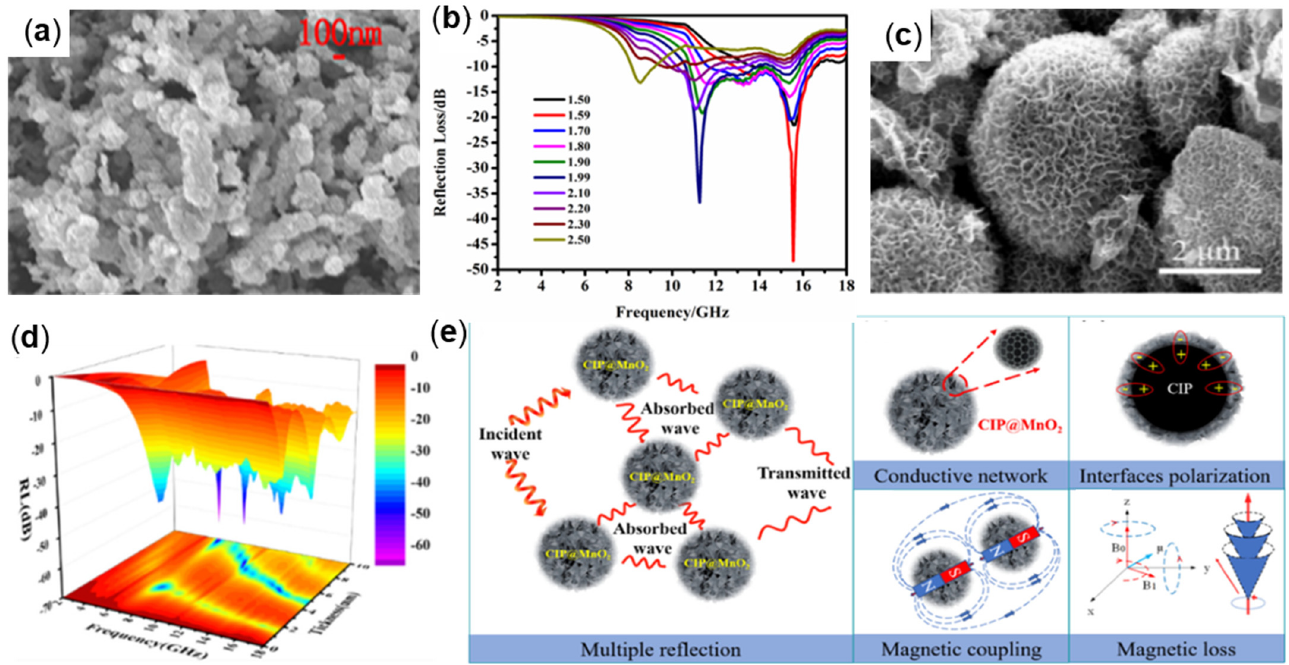
Figure 12. ( a ) SEM and ( b ) RL plot of Fe/ZnO, Reproduced with permission from Ref. [92], Copy- right 2021, Elsevier. ( c ) SEM and ( d ) RL plot of CIP@MnO 2 and ( e ) wave absorption mechanism of CIP@MnO 2 composites with a spherical flower-like structure. Adapted with permission from Ref.